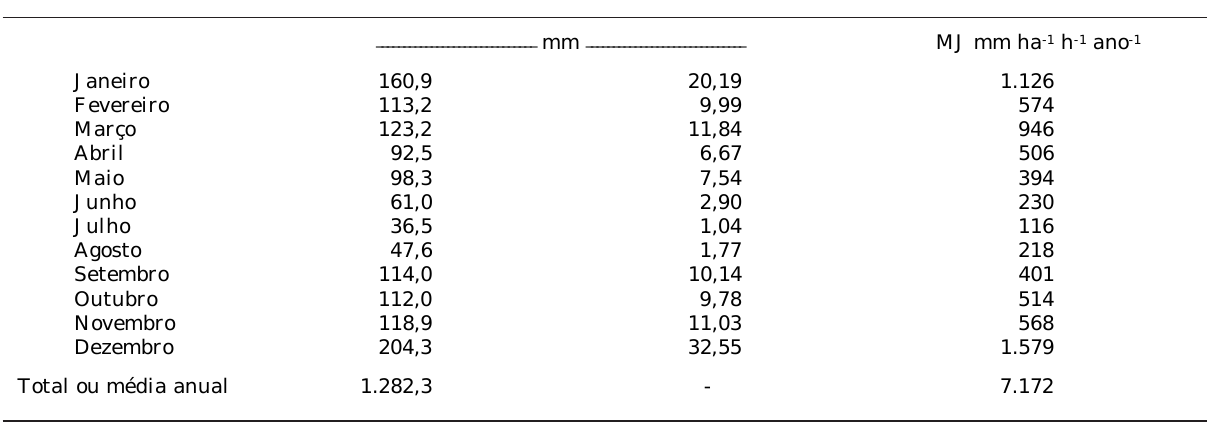
Quadro 3. Valores médios mensais e média anual de precipitação pluviométrica, coeficientes de chuva e parâmetro de erosividade EI de Teodoro Sampaios (SP) no período de 1976 a 30